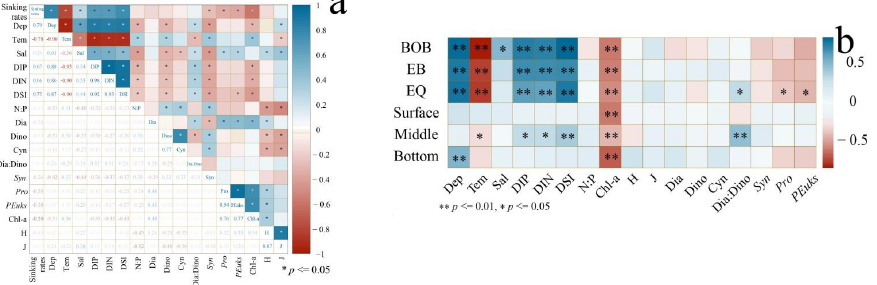
Figure 7. Correlation analysis in the eastern Indian Ocean in spring 2017. ( a ) Relationship between environmental factors, phytoplankton, and sinking rates in the eastern Indian Ocean (). ( b ) Correla ‐ tions between sinking rates and biochemical factors in different sub ‐ regions and at different depths. Pearson correlation coefficients (r) ranged from negative to positive. ** p < 0.01; * p < 0.05 (two ‐ tailed). The top six predictors of the ABT model were nonlinearly fitted using GAMs. The temperature, Chl ‐ a , depth, DIN, DSi, and ratio of diatom to dinoflagellates were also strong predictors of the sinking rates in the water column in our GAMs (Figure 8, all p < 0.05). The effect of temperature on sinking rates showed a strong correlation with temper ‐ ature, with a broad peak at 22–23 °C and a subsequent increase. Chl ‐ a and sinking rates showed more volatility at 0.25 μ g/L, 0.50 μ g/L, and 0.75 μ g/L. Generally speaking, the sinking rates decrease with the increase in chlorophyll concentration. For depth, DIN, and DIP, there is an inflection point between them and sinking rates. Comparing the vertical distribution of nutrients, it can be seen that they are all near the thermocline of tempera ‐ ture. In addition, the sinking rates increased slowly with an increase in the proportion of diatoms and dinoflagellates.